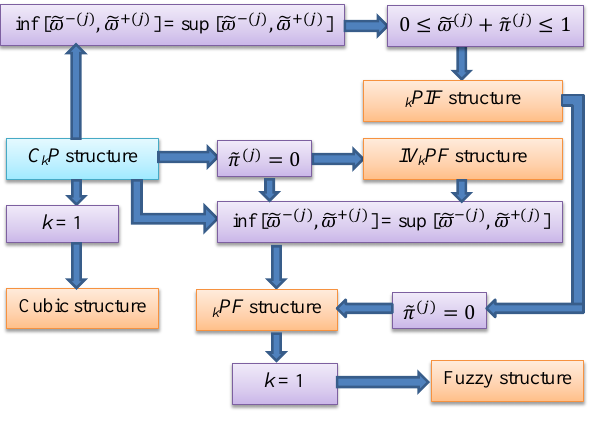
Figure 1. Relationship between a C k P structure and other hybrid FSs